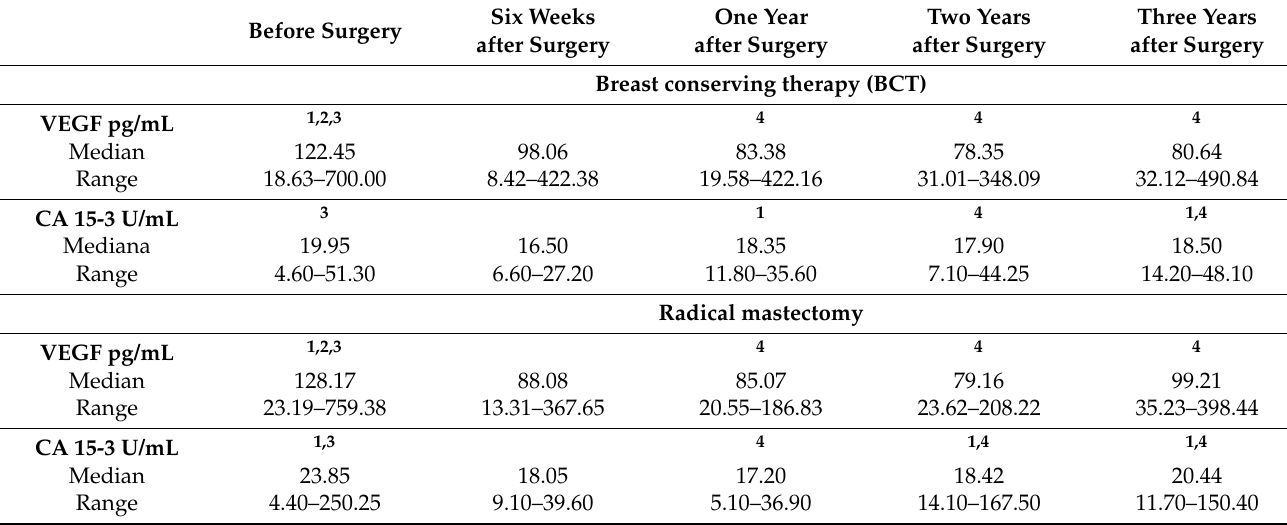
Six Weeks One Year Two Years Three Years after Surgery after Surgery after Surgery after Surgery Breast conserving therapy (BCT)